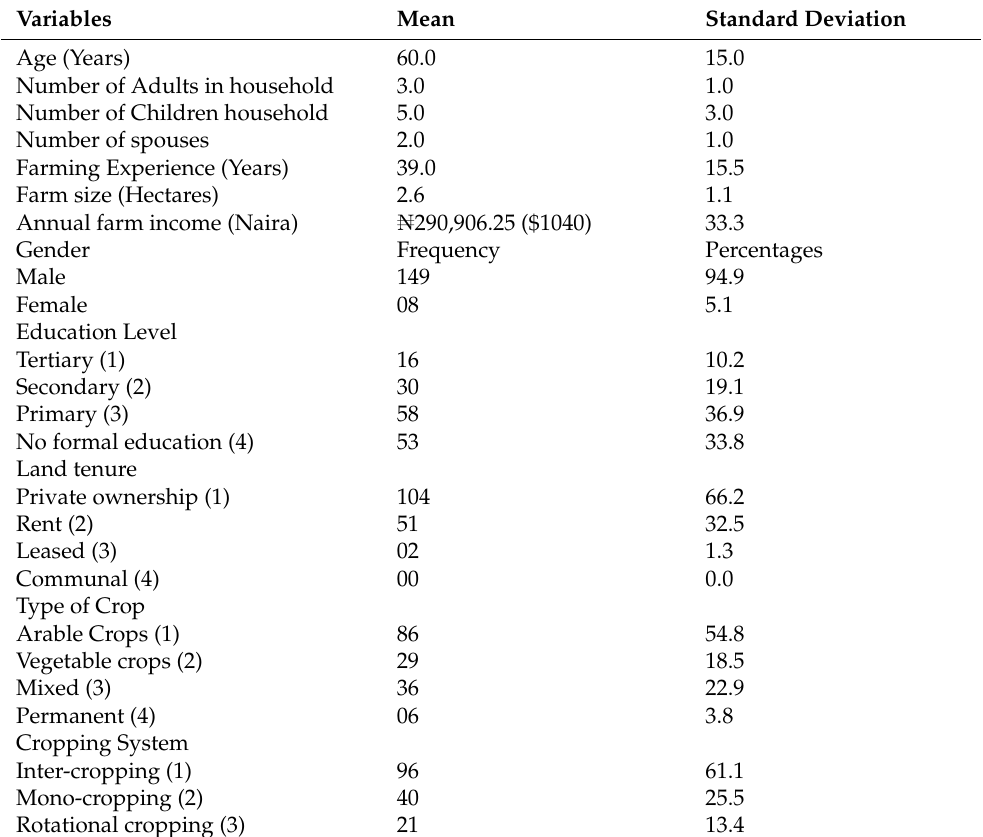
Table 1. Result of the household survey showing farmers’ demographic and farm characteristics in Benue state, Nigeria (n =